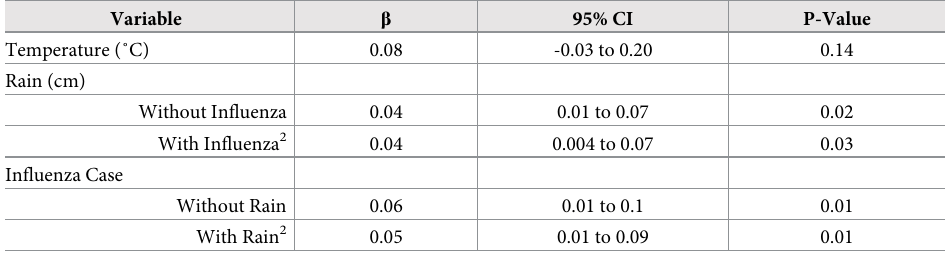
Table 2. Multivariate poisson regression of temperature, rain and influenza on pediatric TB cases, Kampala, Uganda, 2010–2014 1